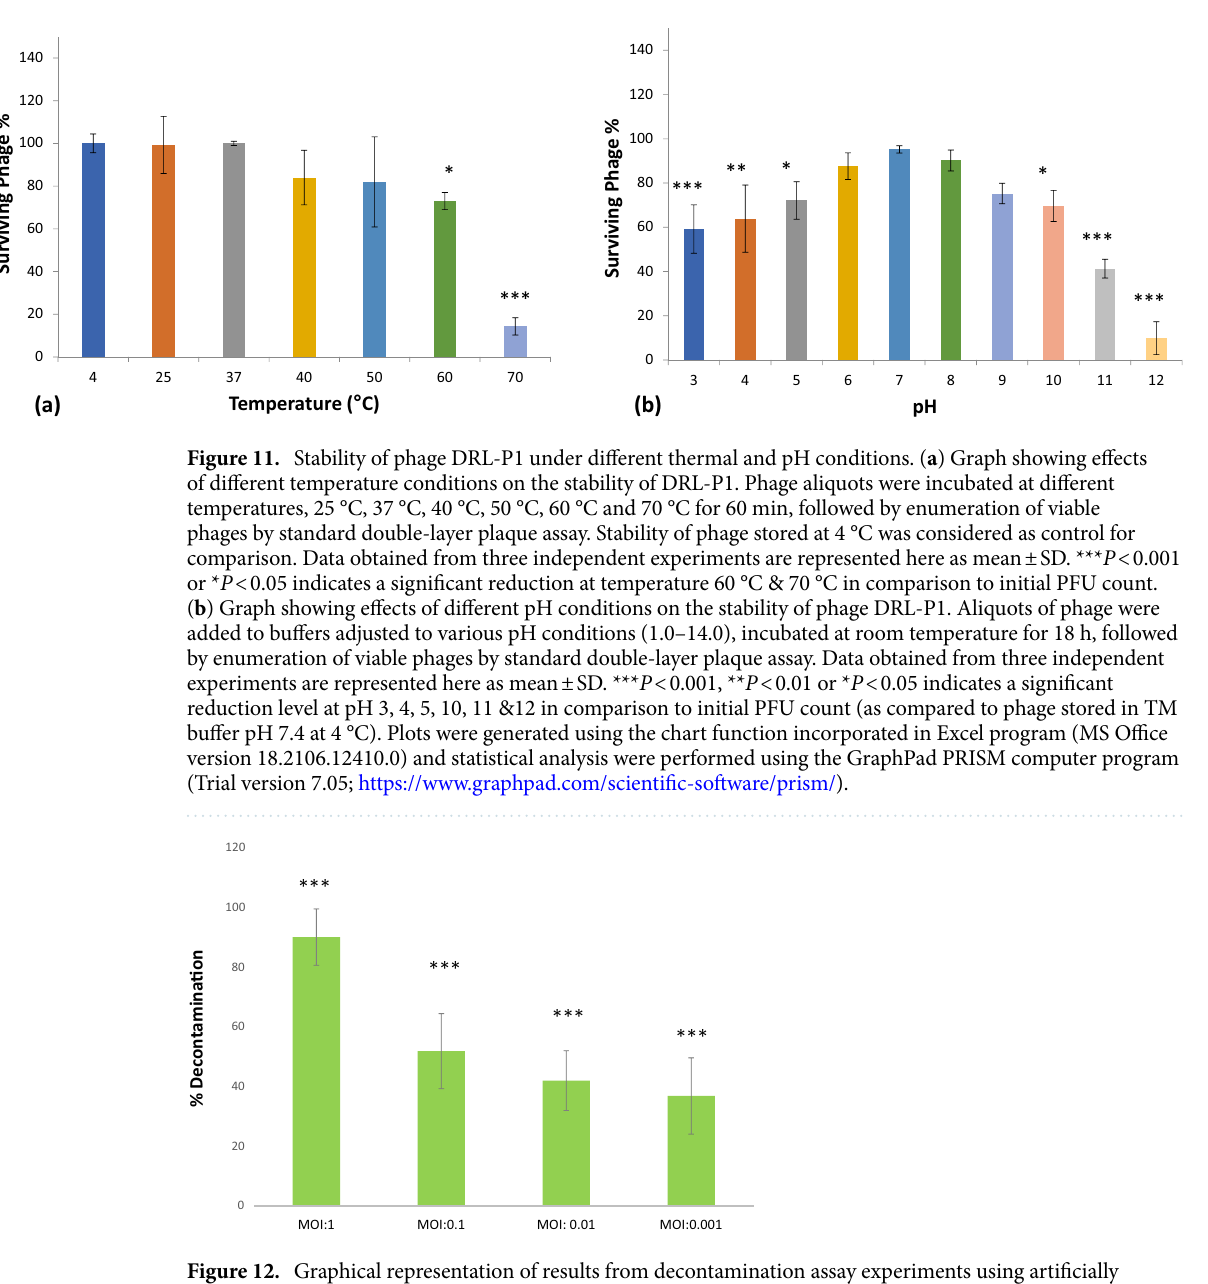
Figure 12. Graphical representation of results from decontamination assay experiments using artificially contaminated cover-slip model for contaminated surfaces. Decontamination of artificially contaminated glass cover slip with phage DRL-P1 application at different MOI (1.0, 0.1, .01, .001). MOI:0 represents control (no phage treatment). Bars represent average % reduction of P. aeruginosa after phage treatment at different MOIs. Data represents mean ± SD from the triplicate experiments. *** P < 0.001 indicates a significant difference between phage treatment at different MOI and the control with no phage treatment. Plots were generated using the chart function incorporated in Excel program (MS Office version 18.2106.12410.0) and statistical analysis were performed using the GraphPad PRISM computer program (Trial version 7.05; https:// www. graph pad. com/ scien tific- softw are/